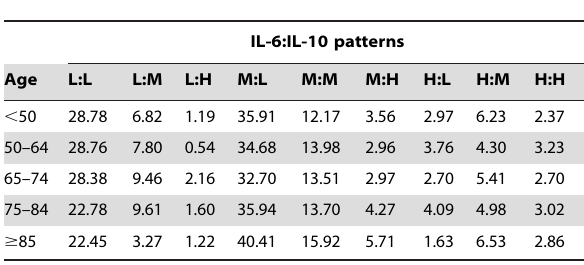
Table 3. Frequency (%) of group membership of IL-6:IL-10 patterns based on trajectory analysis over the first week of